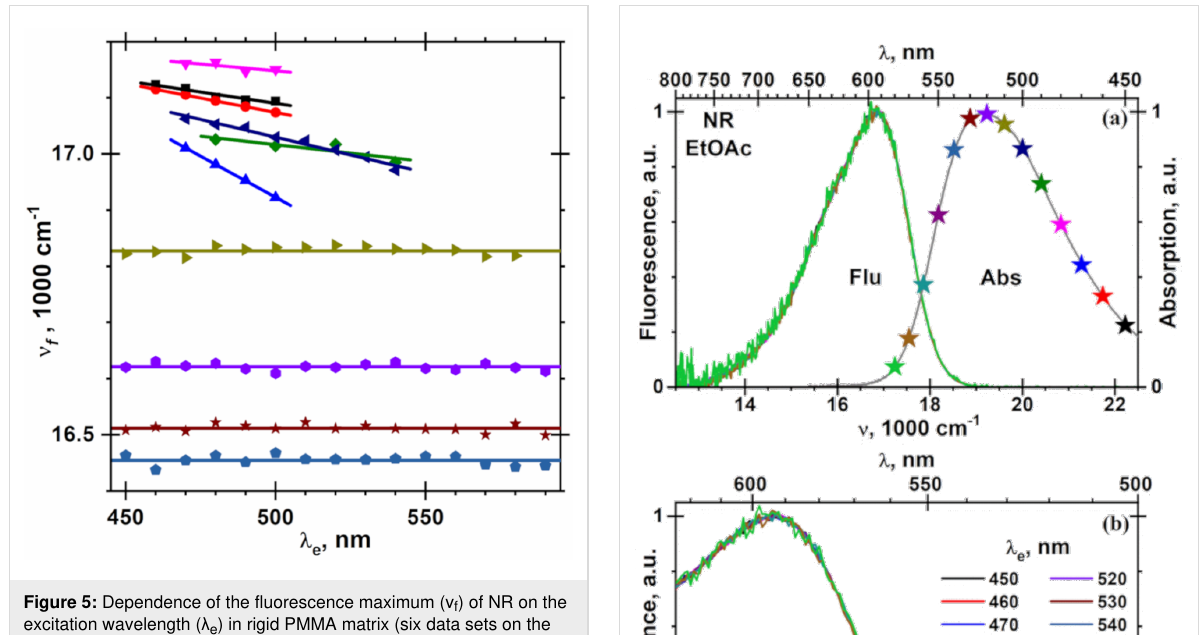
The value of ν f decreases in the series of the spin-coating sol- vents dichloromethane, chloroform and 1,2-dichloroethane.